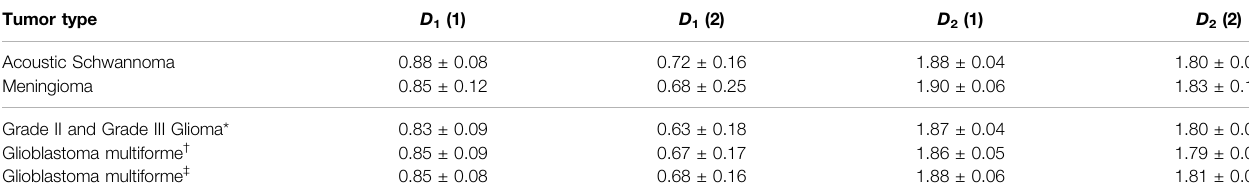
TABLE 6 | Generalized fractal dimensions obtained by Detrended Fluctuation Analysis on one dimensional ordered series, D 1 (1) and D 1 (2), and two dimensional interface data space r ( n ϕ , n Z ). Tumor